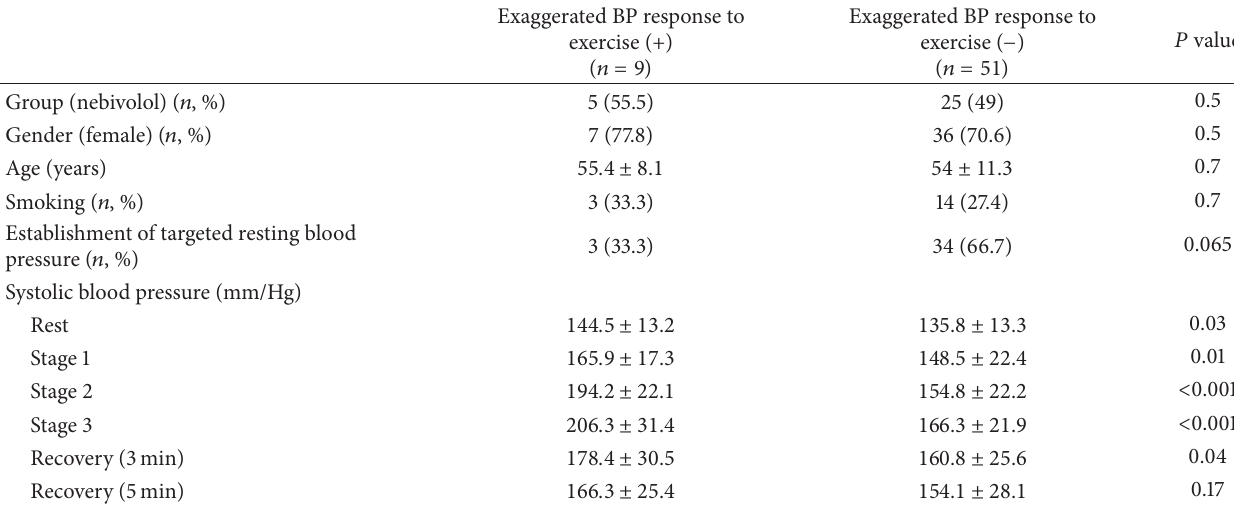
Table 4: The features concerning the patients developing normal and exaggerated blood pressure response to exercise.